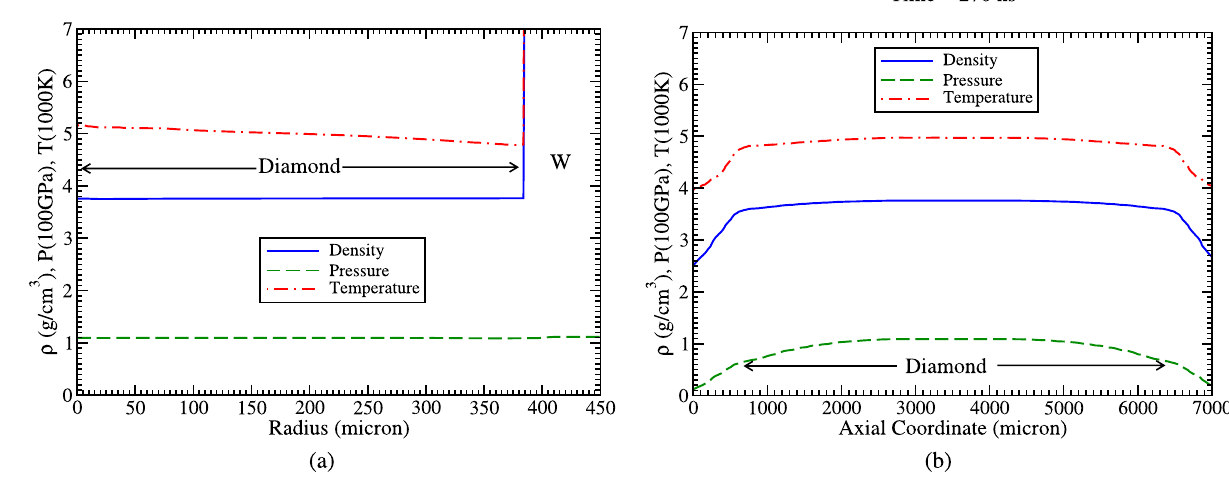
Figure 11. Achieved density, temperature and pressure profiles at t = 270 ns, ( a ) along radius at the middle of the axis and ( b ) along the axis (r = 0).